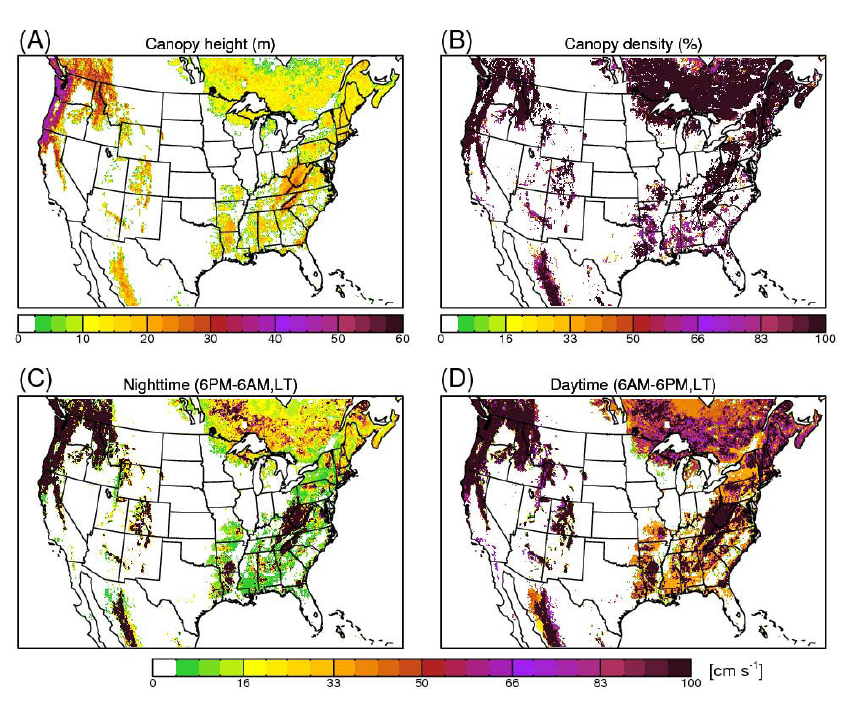
Figure 1. Satellite derived canopy height and density from MOderate Resolution Imaging Spectroradiometer (MODIS) and Geoscience Laser Altimeter System (GLAS) [76]: ( A ) height (m); ( B ) density (%); and difference plot for inverse of aerodynamic resistance, 1 − (cm s − 1 ) between the case with z r obtained with satellite observation of canopy height 0 a multiplied by 0.136 and that given by the MET model for ( C ) nighttime hours between 6:00 pm and next day 6:00 am local time; and ( D ) daytime hours between 6:00 am and 6:00